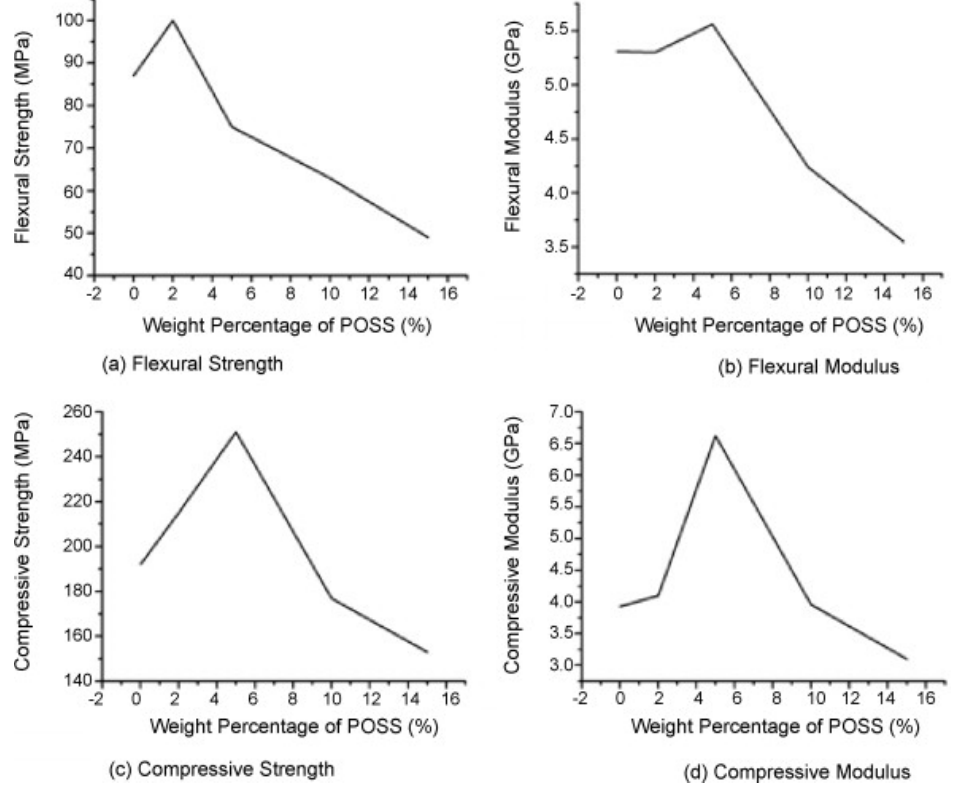
Figure 7. Flexural strength (top left), flexural modulus (top, right), compressive strength (bottom, left) and compressive modulus (bottom, right) of POSS-methacrylate nanocomposites are plotted vs. amount of POSS. Reproduced with permission from Wu et al . [83]. Copyright 2010,